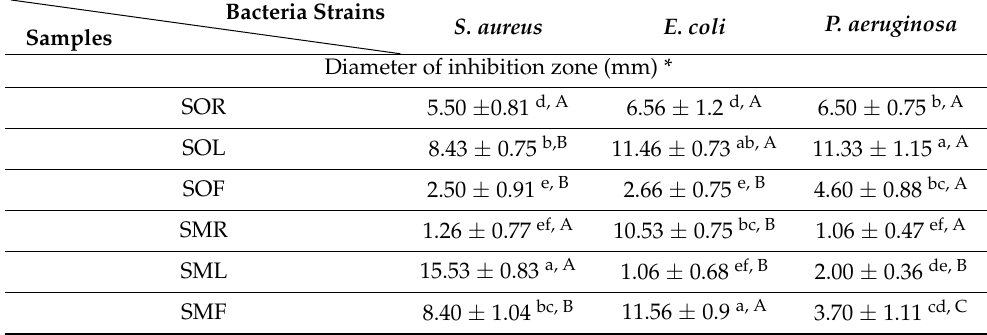
Table 2. Antimicrobial activity of tested extracts from the roots, leaves and flowers of S. officinalis L. and S. minor